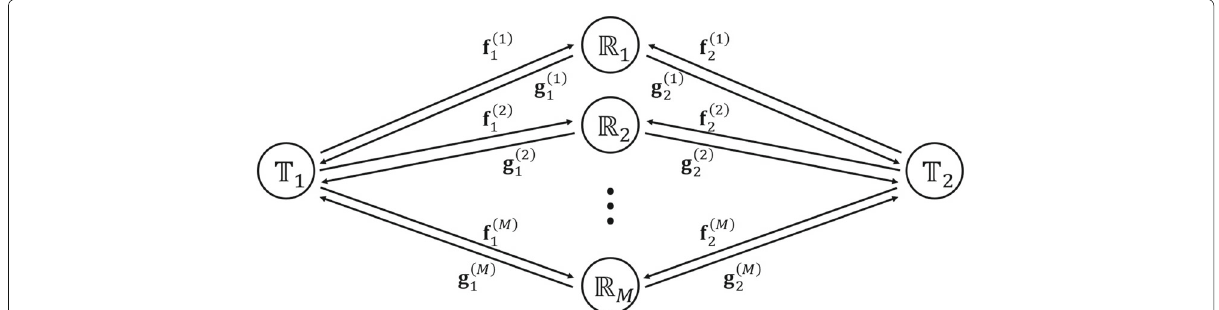
Fig. 2 System configuration for multiple relay network. It shows the case of multiple relay nodes. Suppose that we have M relay nodes R R ... , R 1 , 2 , M . Let the channels from